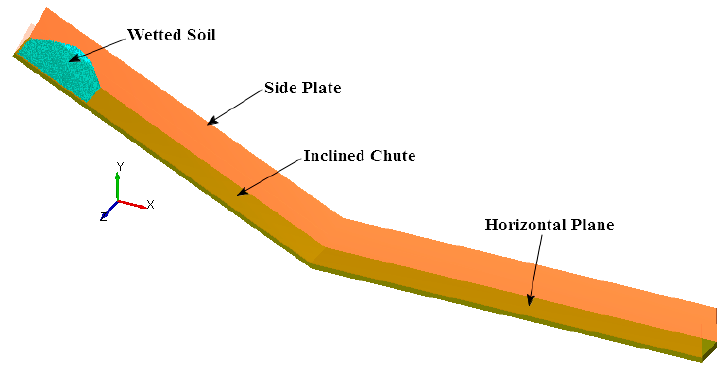
Figure 6. Inclined chute DEM model of wet soil granular flow of Case 1.